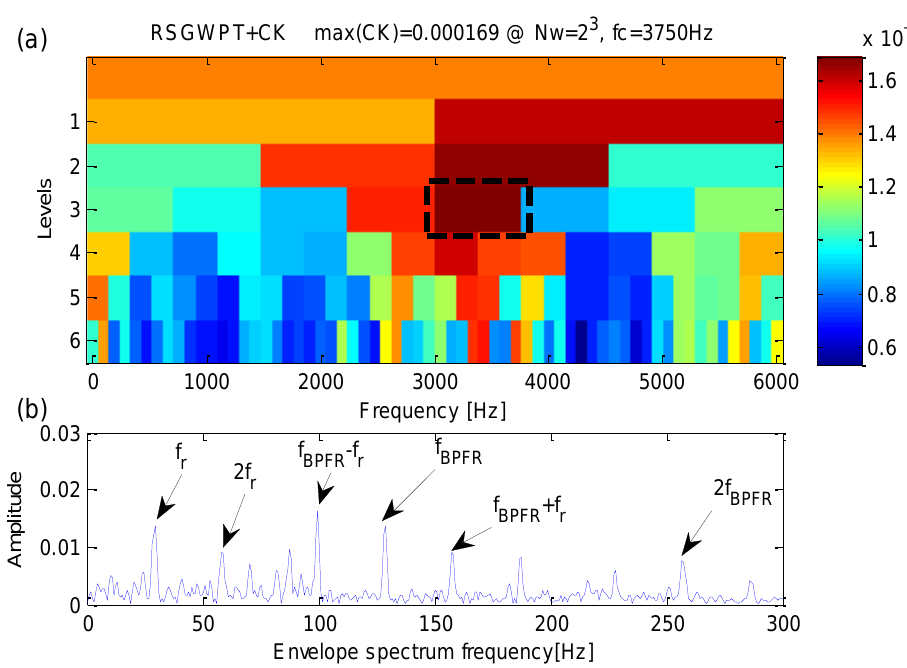
Figure 17. ( a ) The improved kurtogram of data X224_DE; ( b ) the envelope spectrum of the frequency band with the maximum correlated kurtosis.